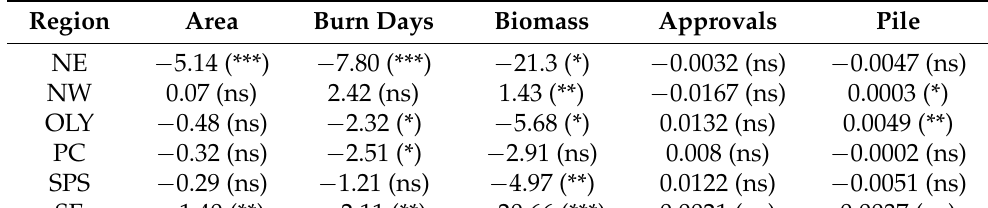
Table 3. Annual trends in five prescribed fire parameters from 2004–2019 for each DNR adminis- trative region (Northeast (NE), Northwest (NW), Olympic (OLY), Pacific Coast (PC), South Puget Sound (SPS), and Southeast (SE)). p -values greater than 0.03 are interpreted as not significant (ns), p -values less than 0.03 are interpreted as significant (*), p -values less than 0.0075 are interpreted as strongly significant (**), and p -values less than 0.0005 are interpreted as very strongly significant (***). See Section 2.2.1 for details.